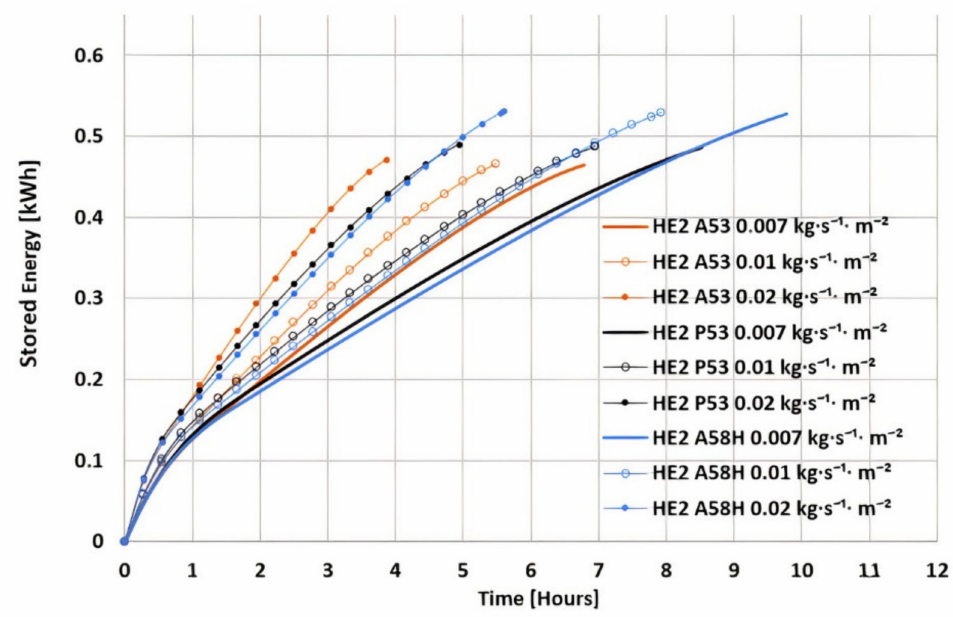
Figure 10. Stored energy during charging for all PCMs and all HTF flow rates studied, for HE2.